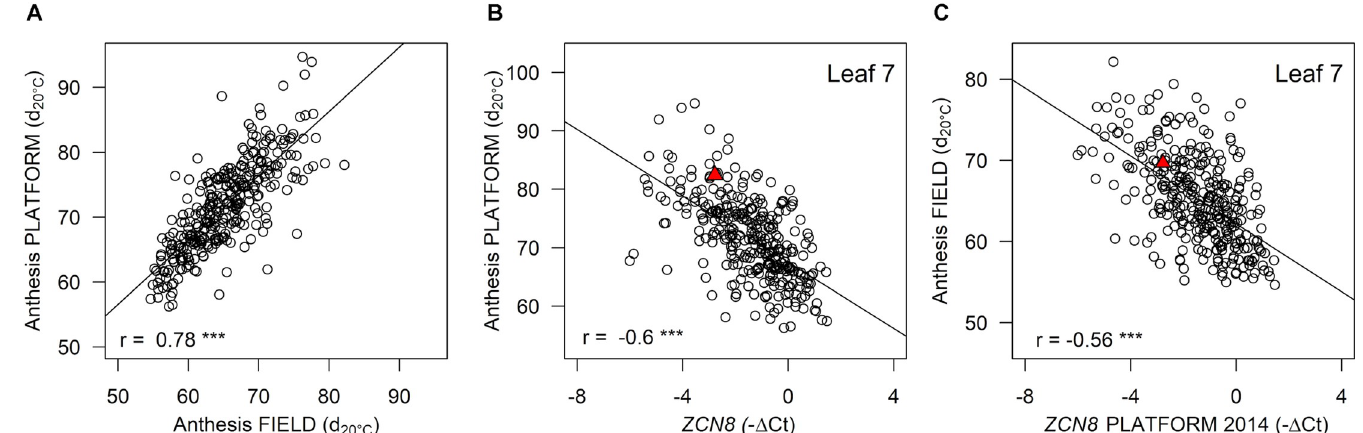
Fig 1. ZCN8 contributes to flowering time variability in temperate maize lines. (A) Relationship between genotypic values for anthesis in field (2015–2016) and platform (2014) experiments. (B) Anthesis time plotted against ZCN8 expression after the floral transition (platform experiment in 2014). (C) Relationship between anthesis measured in the field (2015–2016) and ZCN8 expression in the platform experiment (2014). In (A), (B) and (C) n = 313 lines. Genotypic values are BLUEs. Anthesis time expressed in equivalent days at 20˚C after germination. The red triangle represents genotypic values for the reference line B73. Correlation coefficients are displayed together with their significance ( ��� p < 10 − 4